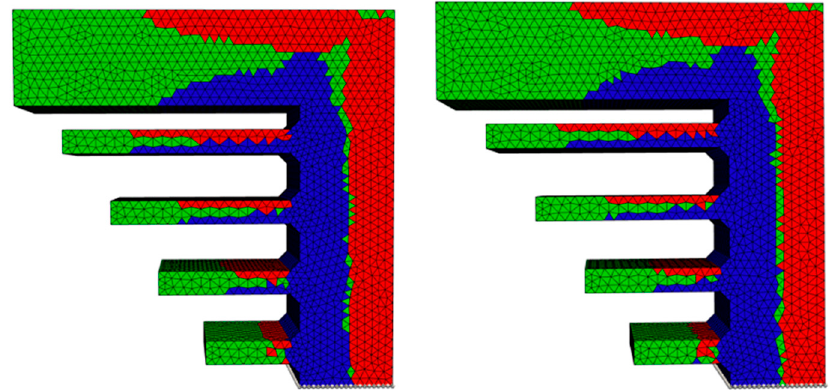
Figure 11. Comparison of STEP ( left ) and STL ( right ) structure types, exemplary shown for the quadratic meshed staircase.